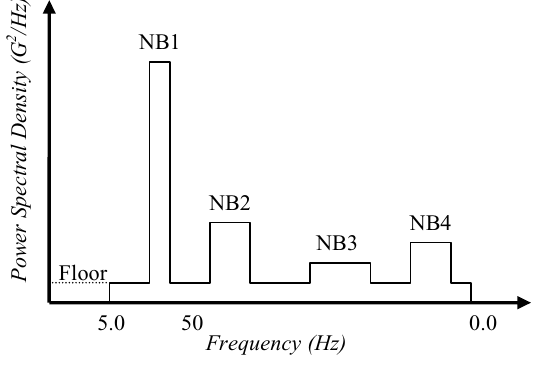
Fig. 2. Acceleration power spectral